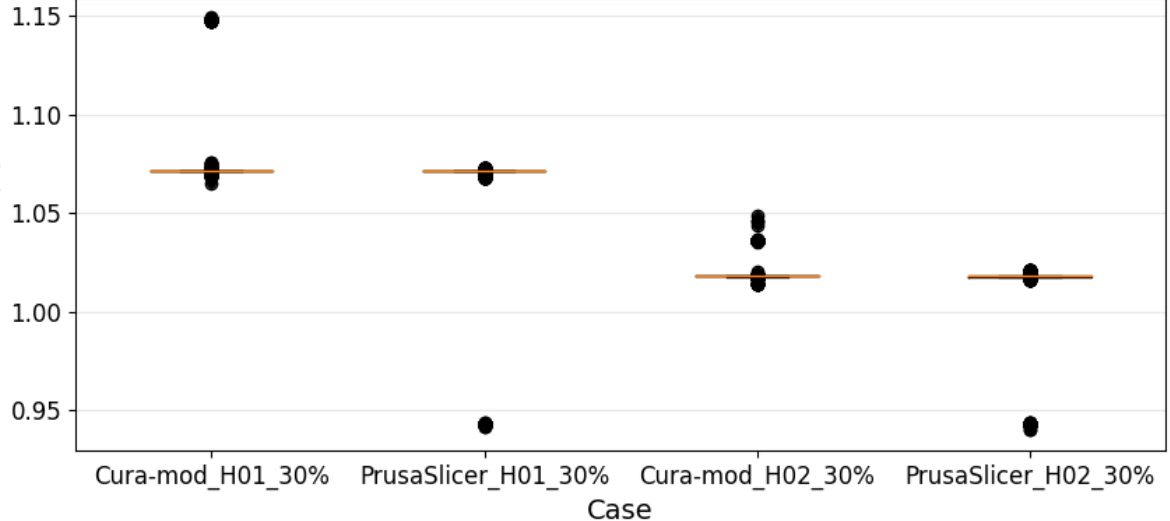
Figure 13. Volumetric fill for the fibers.